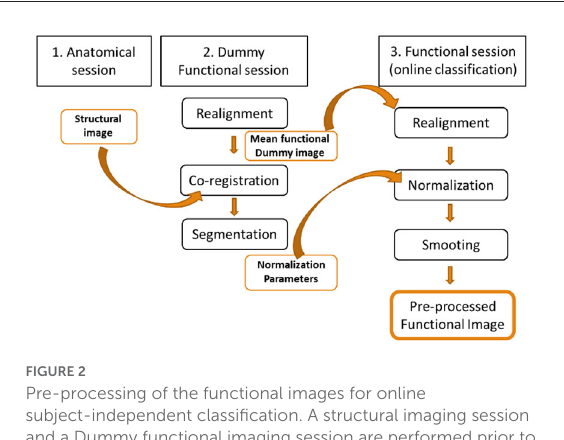
FIGURE3 Group classifier accuracy per day. (Mean ± SD; 2-tailed t-test; one-sample z test against zero)